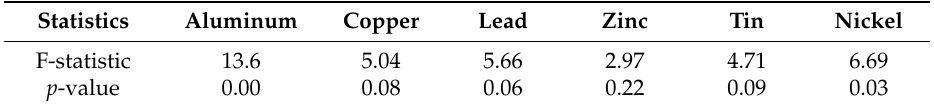
Table 7. Joint hypothesis testing: monthly data analysis